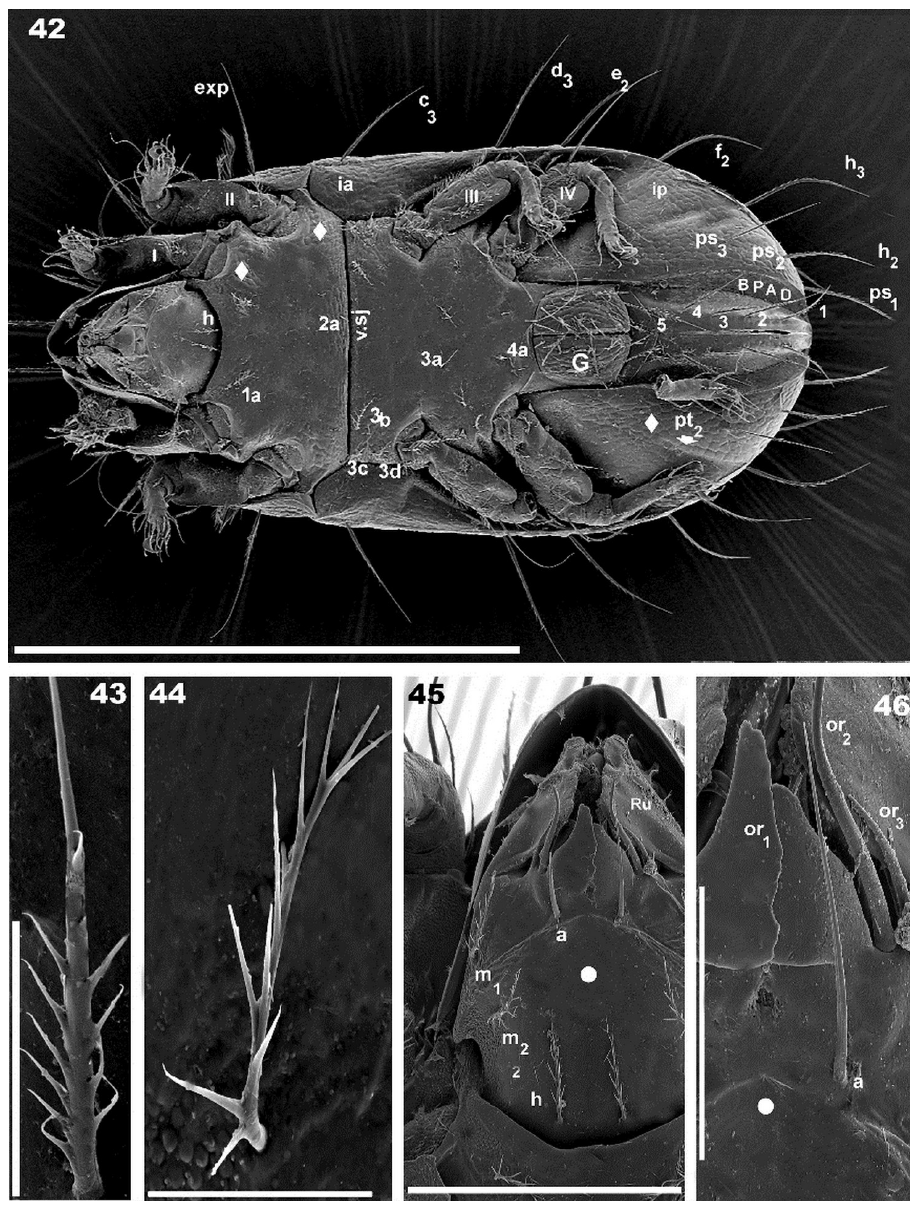
Figures 42–46. Torpacarus eidikoterai sp. n. Adult female with cerotegumental layer. SEM micrographs. 42 ventral view 43 subcapitular h setae 44 epimeral setae 45 subcapitulum ventral view 46 adoral setae. Scale bars: 500 μm ( 42 ); 20 μm ( 43 ); 20 μm ( 44 ); 100 μm ( 45 ); 30 μm ( 46